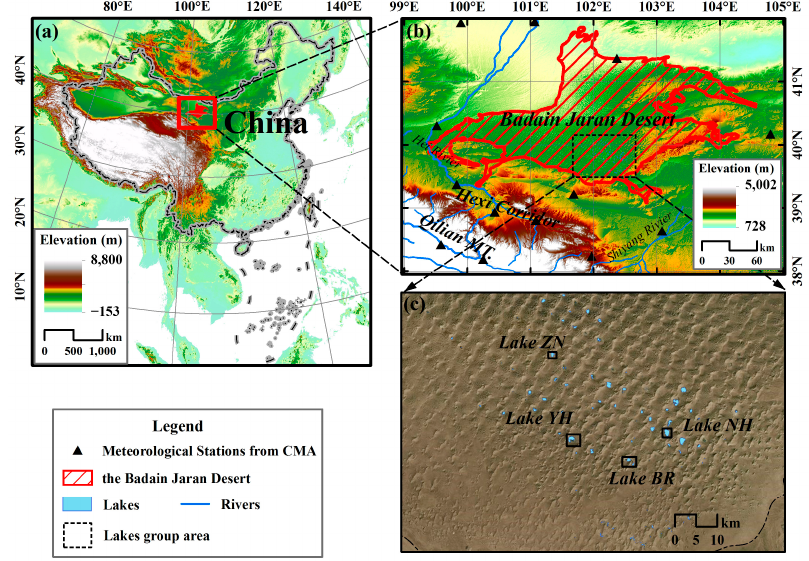
Figure 1. ( a , b ) The location of the BJD (Badain Jaran Desert) region in China; ( c ) the location of the lake group area in the BJD and four lakes where the lake water level was monitored by in situ instruments in this study.